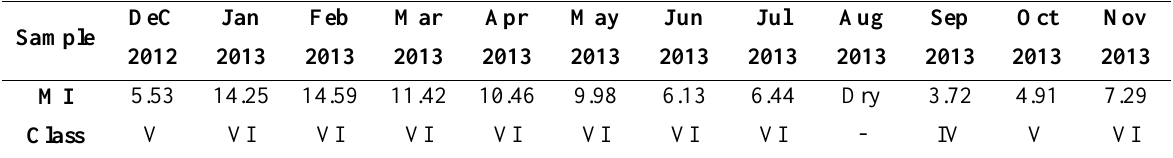
Table 4 Metal Index (MI) of studied samples of Silakhor River at various sampling